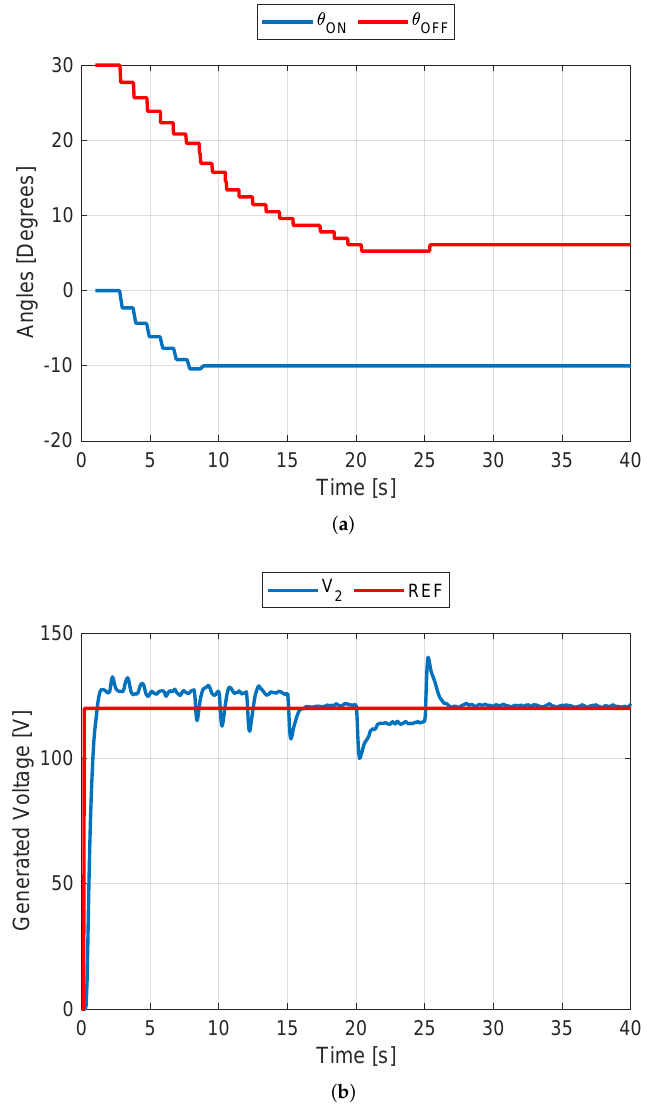
Figure 15. Simulation result for 120 V reference: ( a ) Evolution of angles θ ON and θ OFF with MEPT algorithm; ( b ) Performance of voltage controller in parallel with MEPT